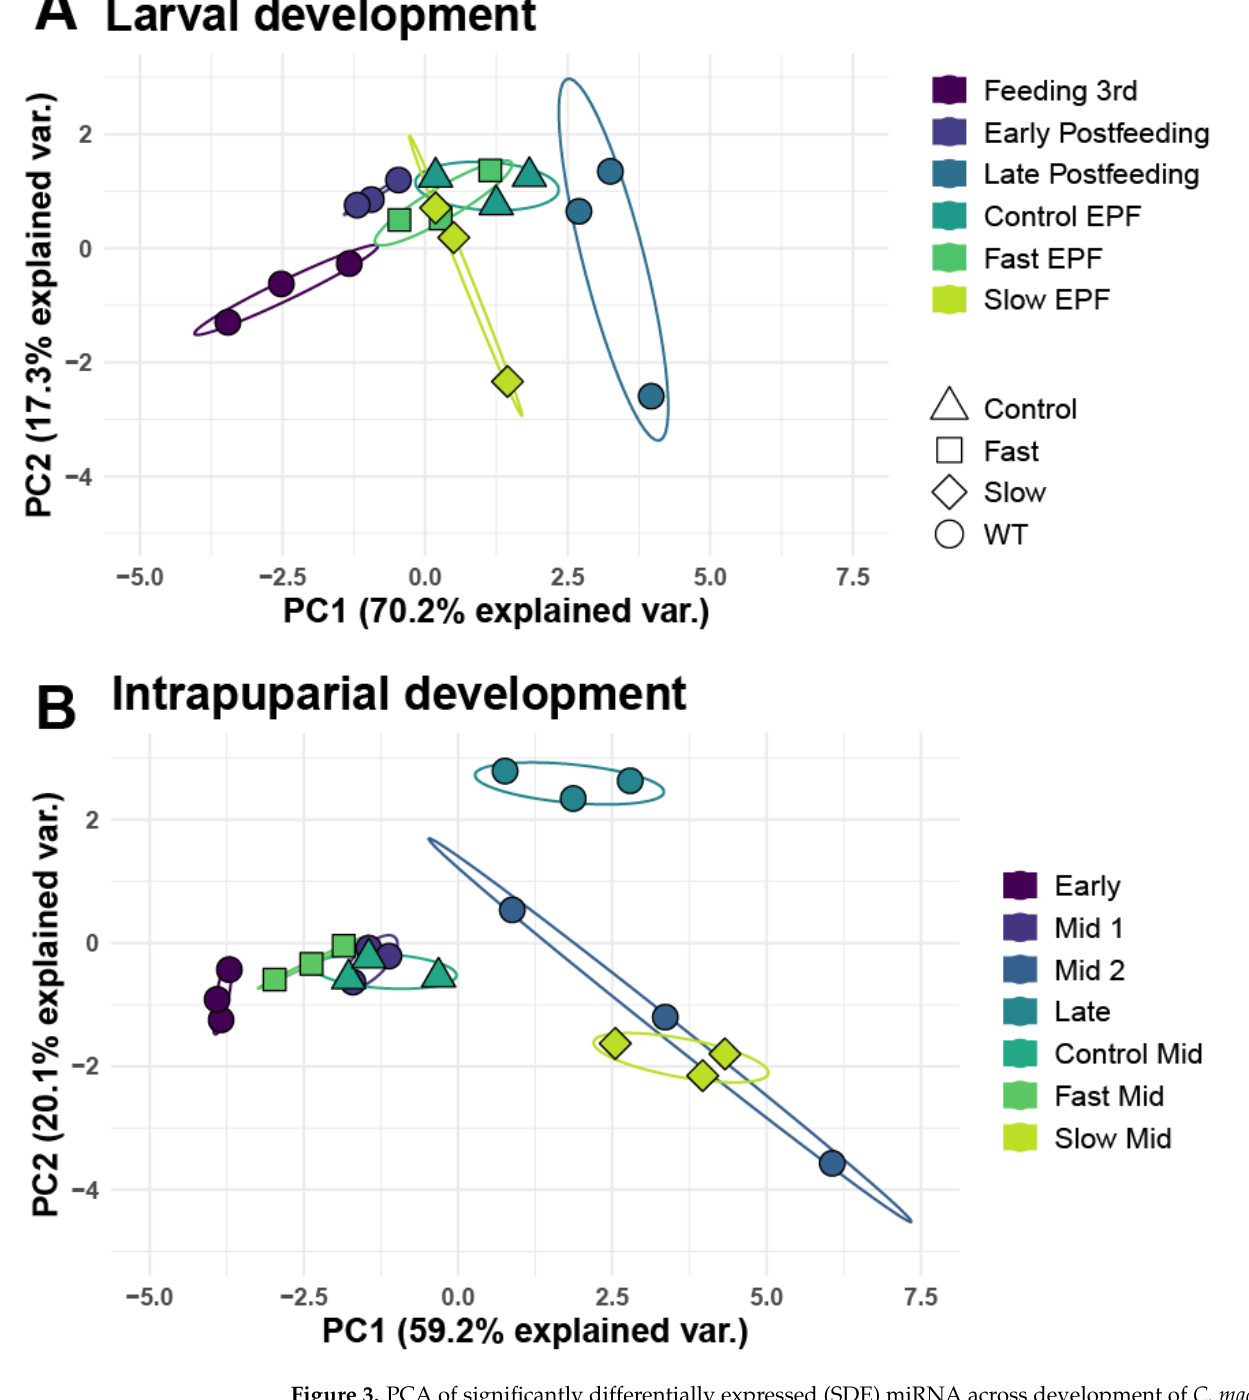
Figure 3. PCA of significantly differentially expressed (SDE) miRNA across development of C. macellaria. PCA of normalized expression of miRNA identified to be SDE in wild-type samples (circles) ( A ) PCA of larval development time points could explain 87.5% of the variance between the first two principal components. ( B ) PCA of intrapuparial development time points could explain 79.3% of the variance between the first two principal components. Samples selected for fast development time (square), slow development time (diamond), and their controls (triangle) were projected onto the PCA from the wild-type samples to determine clustering position of new samples from the PCA model built from SDE miRNA from wild-type samples.